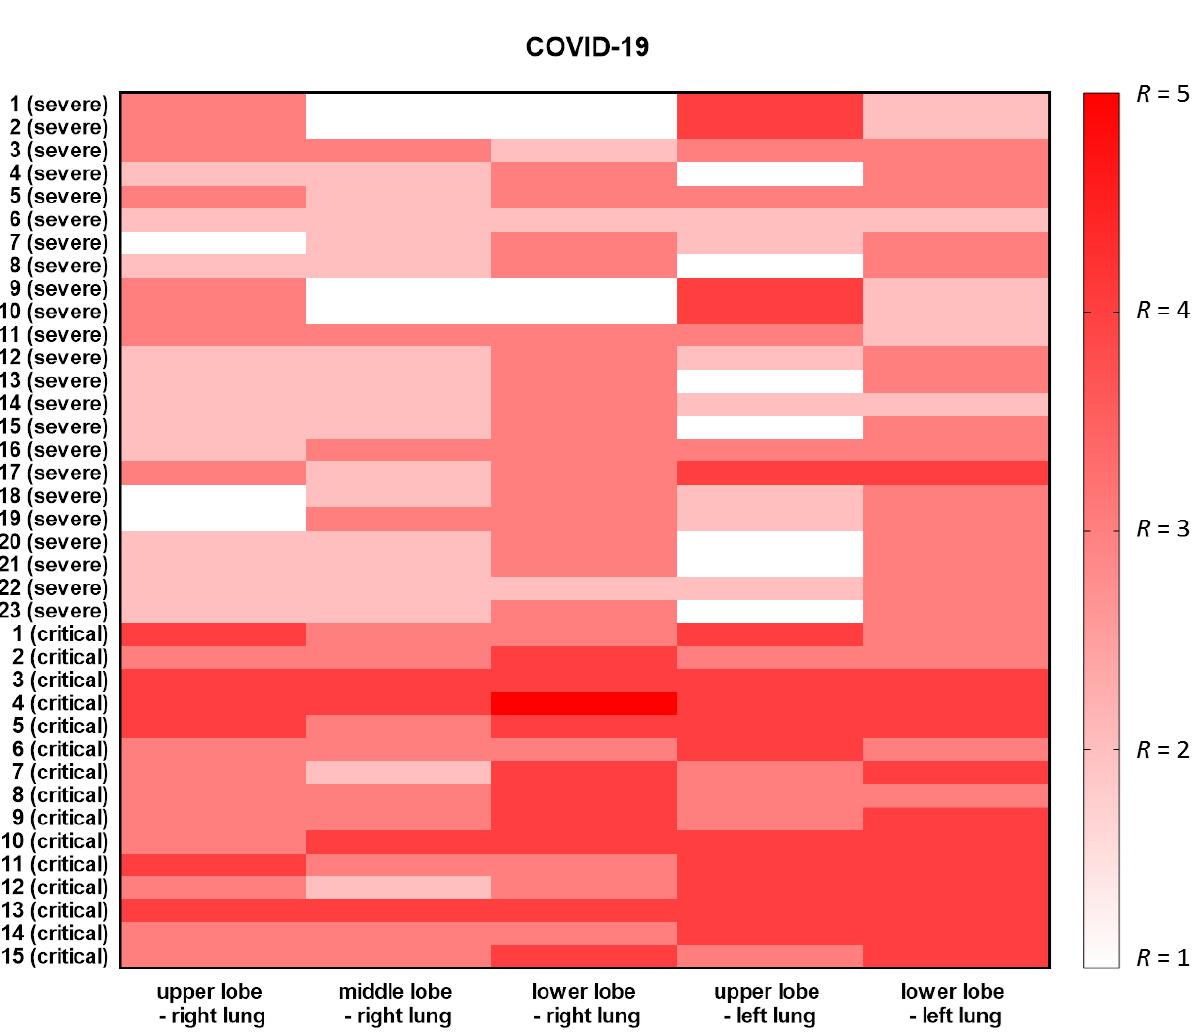
Figure 1. Heatmap with CT severity score in each patient. Lung lesion advancement grading was shown based on visual assessment of the degree of pulmonary tissue involvement by lesions in individual lobes (three lobes of the right lung and two lobes of the left lung). Each lobe was awarded a CT score from 0 (white) to 5 (red), depending on the percentage of the involved lobe.